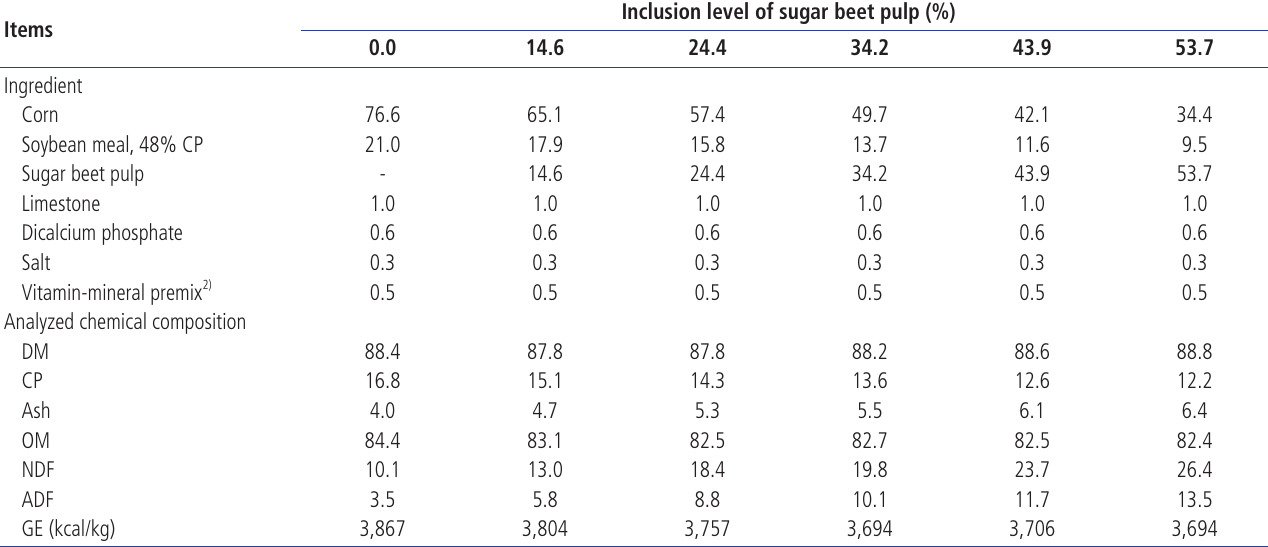
Table 2. Ingredient and analyzed composition of experimental diets in Exp. 1 (%, as-fed basis) 1)